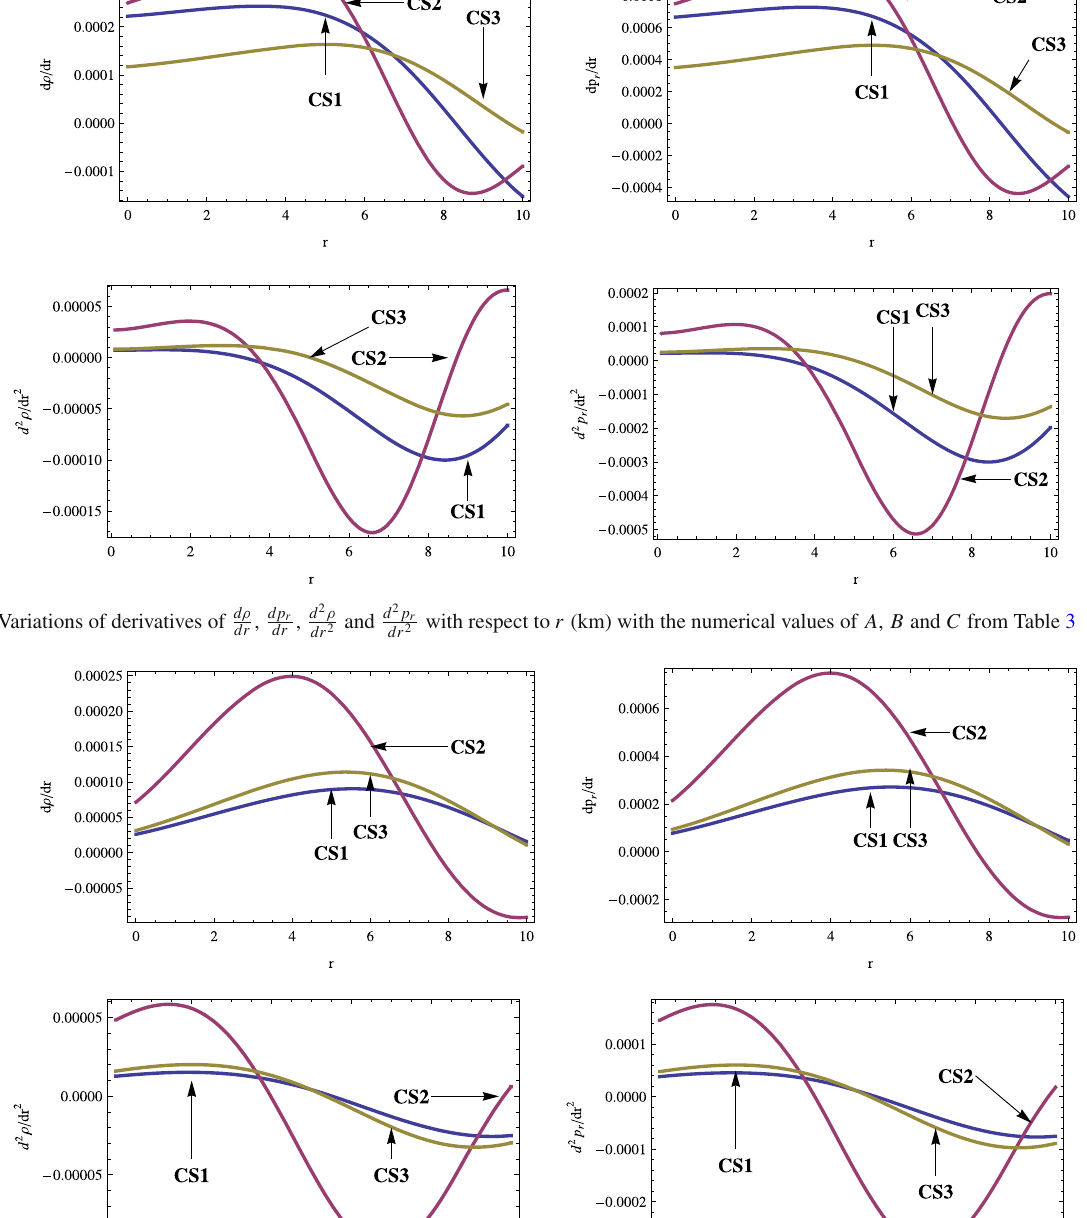
, dp r , d 2 ρ and d 2 p r with respect to r (km) with the numerical values of A , B and C from Table dr dr dr 2 dr 2